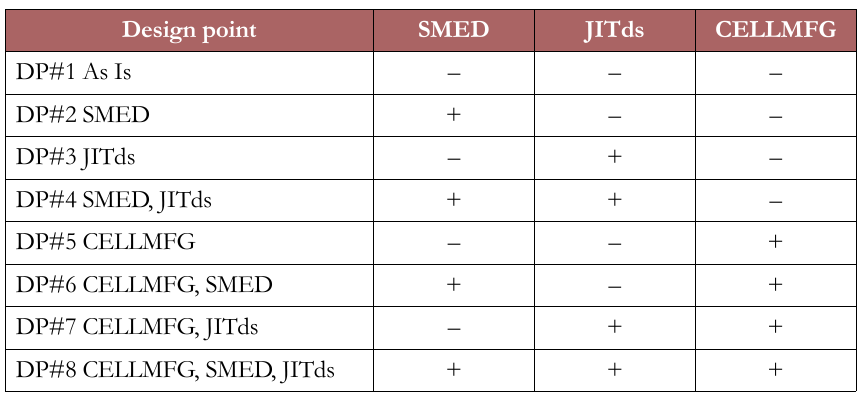
Table 4. Design Points